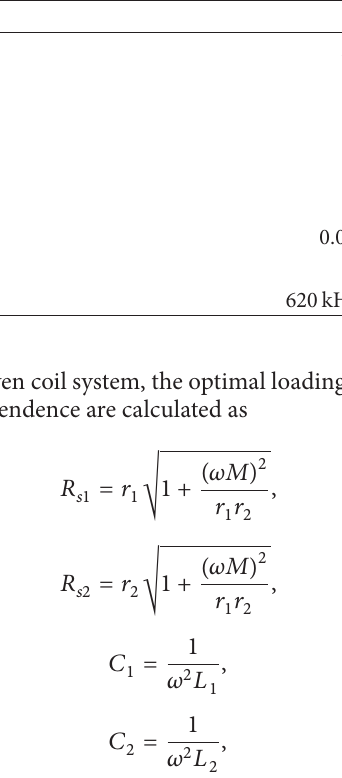
Figure 1: Equivalent circuit model of two-coil WPT system. Table 1: Circuit